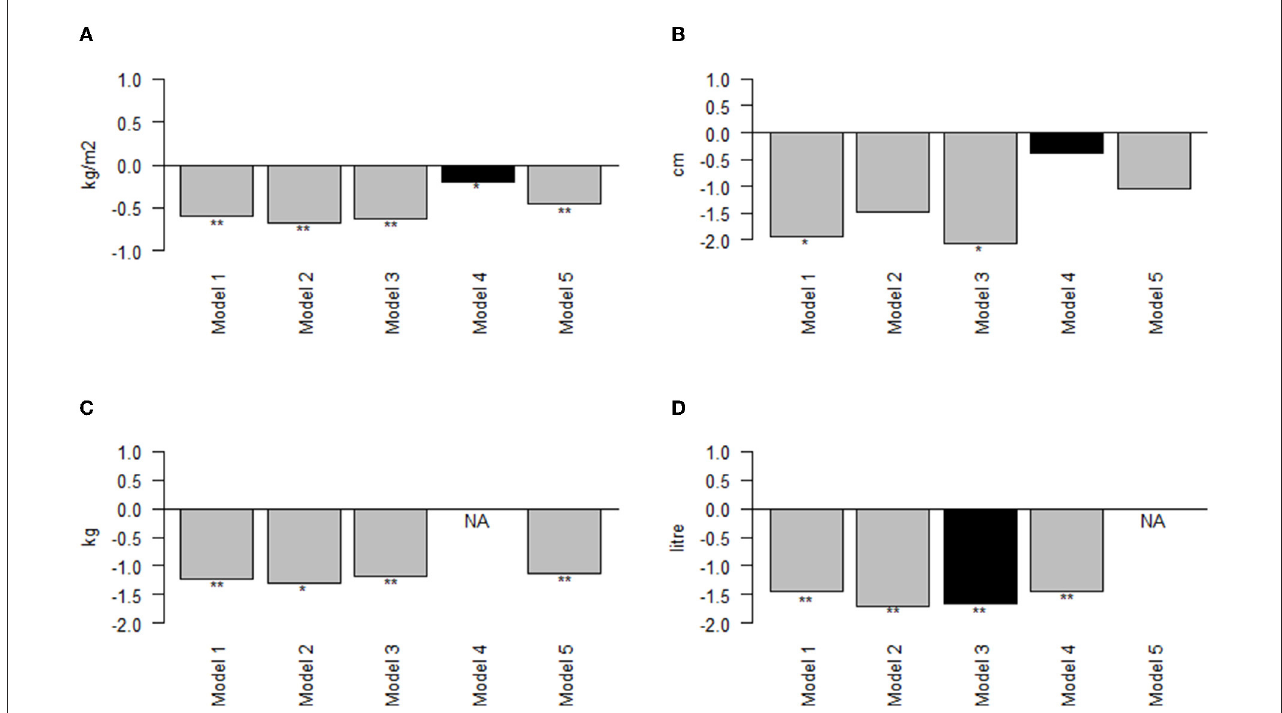
FIGURE1 Effect of adjustments on mean difference in BMI, waist circumference, fat mass and total body water from LORANS . (A) Mean difference in BMI; (B) Mean difference in waist circumference; (C) Mean difference in fat mass; (D) Mean difference in total body water; * : P < 0.05; ** : P < 0.001; NA, the model adjusts for the outcome; Black bar, the outcome is highly correlated (r > 0.6) with the variable adjusted